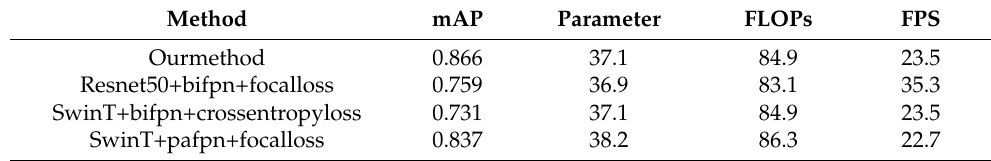
Table 3. Ablation experiments.